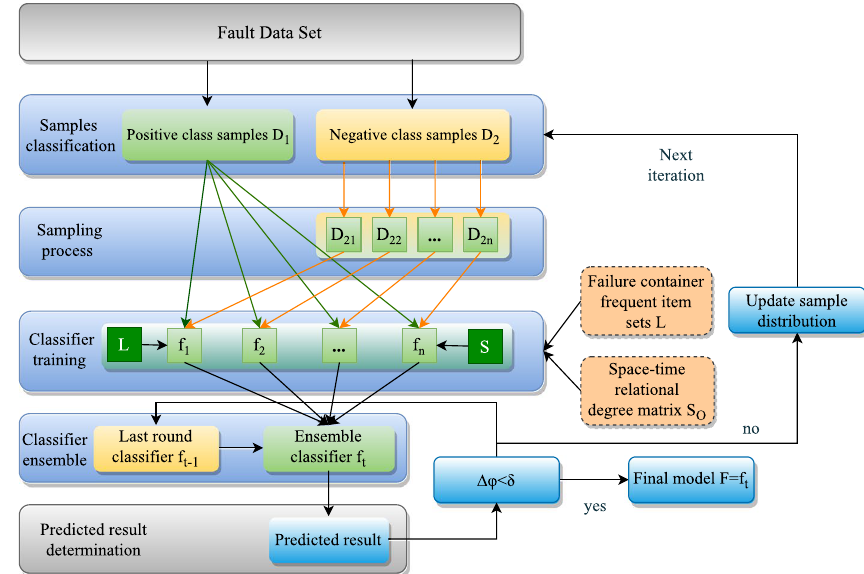
Fig. 6 Model learning method flow for imbalanced fault history